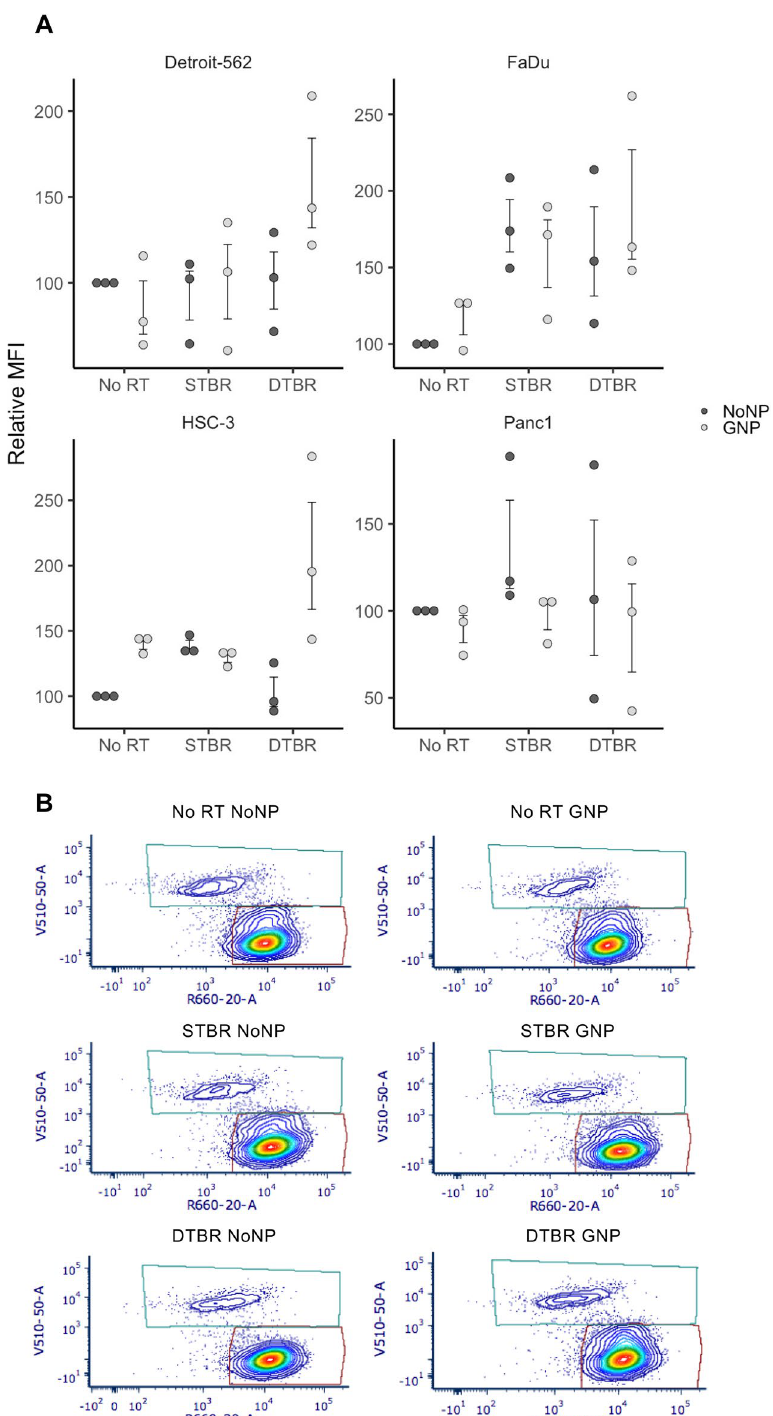
Figure 6. Reactive oxygen species (ROS) were elevated in HNCCs with GNP-facilitated DTBR. Cells were cultured in 6-well plates, irradiated with 8 Gy from the STB or DTB, then processed for flow cytometry 12 h post radiation. ( a ) Detroit-562, FaDu, and HSC-3 HNCC lines showed a trend towards higher levels of ROS in GNP-labeled cells irradiated with the DTB (these increases were not significant). GNP Panc1 cells demonstrated a reduced level of ROS after DTBR. ( b ) Representative flow plots of Detroit-562 cells labelled with CellROX Deep Red Reagent (Ex/Em: 644/665) and SYTOX Blue dead cell stain (Ex/Em: 444/480). Results are presented as means of Relative Median fluorescence intensity (MFI) (where relative MFI = net MFI of treated sample/net MFI of untreated sample × 100) ± standard error of the mean, p* < 0.05, p** < 0.01, p*** < 0.001. Significance between groups was tested using a Mann Whitney test (n = 3; ~ 1 × 10 6 cells per replicate). GNP gold nanoparticles, NoNP no nanoparticles, HNCC head and neck cancer cells, STB(R) standard target beam (radiation), DTB(R) diamond target beam